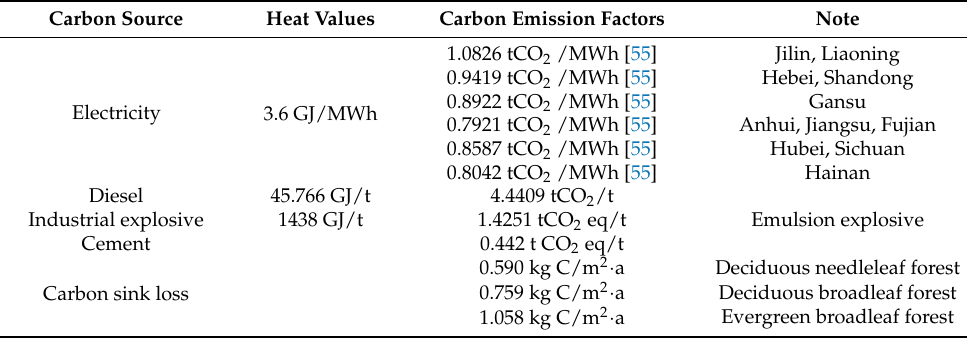
Table A1. Heat values and carbon emission factors of energy or carbon sources.